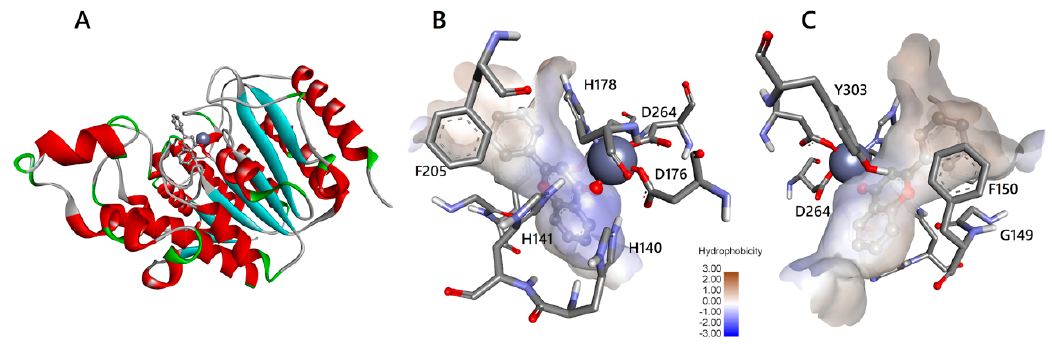
Figure 3. Interaction of flavone with HDAC1. ( A ) HDAC1 (ribbon with red helices and cyan strands) with flavone (grey molecule, in a ball and stick representation) in the interaction resulting from docking simulation. Zinc ion is represented as a sphere. ( B ) flavone (ball and stick) in the catalytic channel (surface coloured by hydrophobicity scale) of HDAC1. Amino acids (sticks) involved in the interaction with flavone are labelled with a one-letter code and number in the sequence. Zinc ion, represented as a sphere, is coordinated with the carbonyl oxygen atom of flavone ring C and D176, H178, D264. Atoms are coloured in grey (Carbon), red (Oxygen), white (Hydrogen), and blue (Nitrogen). ( C ) the opposite view of panel B shows the position of amino acids not visible in the other panel. Images are generated by DiscoveryStudio4.5.